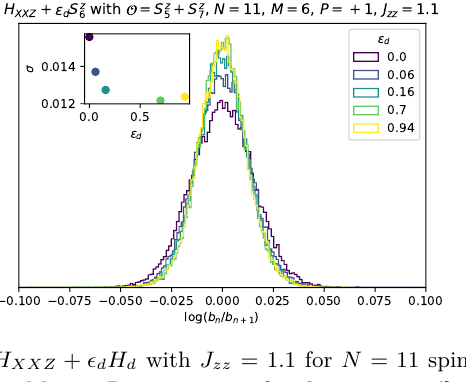
spins in the M = 4 , P = +1 sector for the operator O = S z . 6